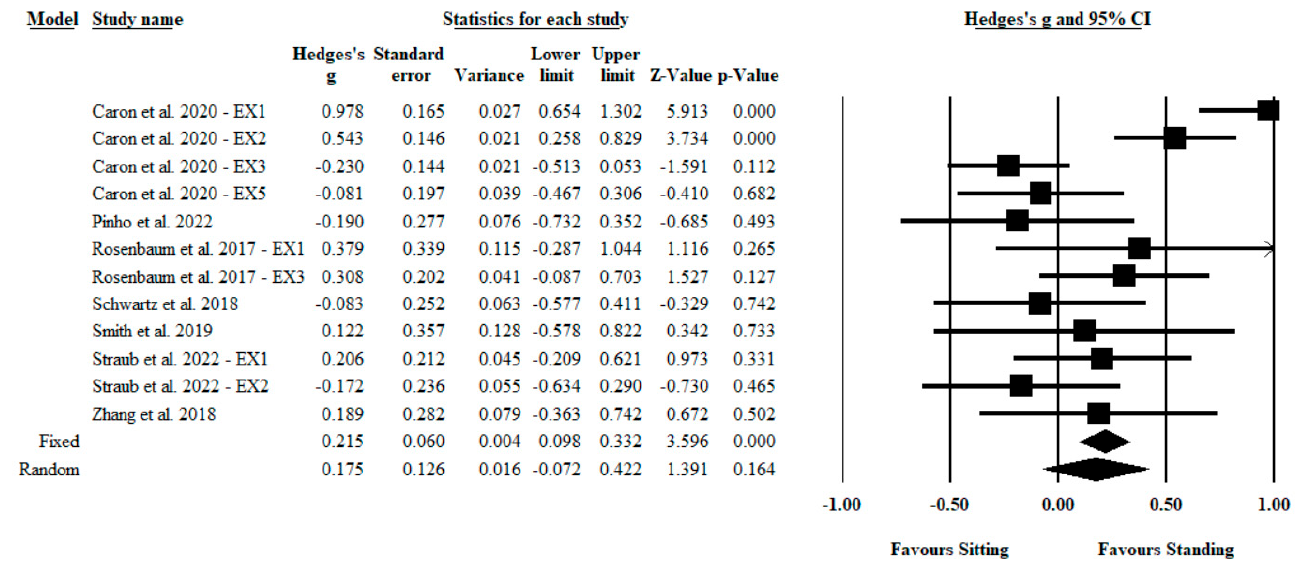
Figure 3. Forest plot of the Hedges’ g differences between sitting and standing conditions for congruent stimuli.